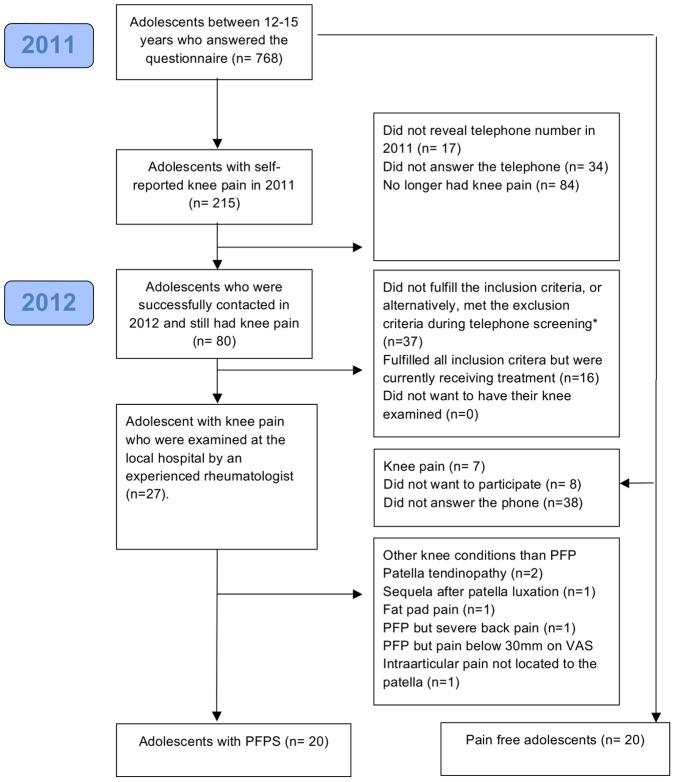
Flow-chart.Flowchart showing recruitment of adolescents with PFPS and gender and age-matched pain free adolescents without knee pain. *Telephone screening: pain for more than 6 weeks; pain felt anteriorly around the patella or diffusely around the knee; no treatment within the previous 12 months, no previous knee surgery and a history of insidious onset of knee pain.